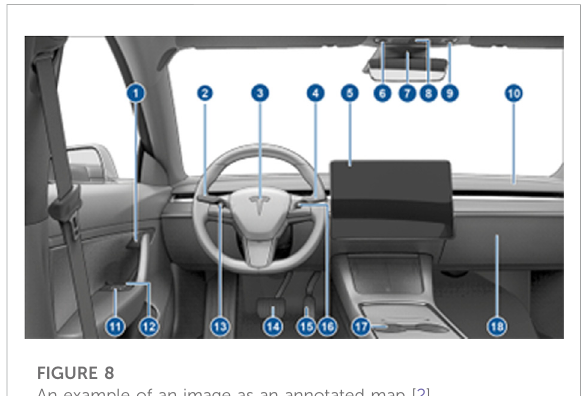
An example of an image as an annotated map